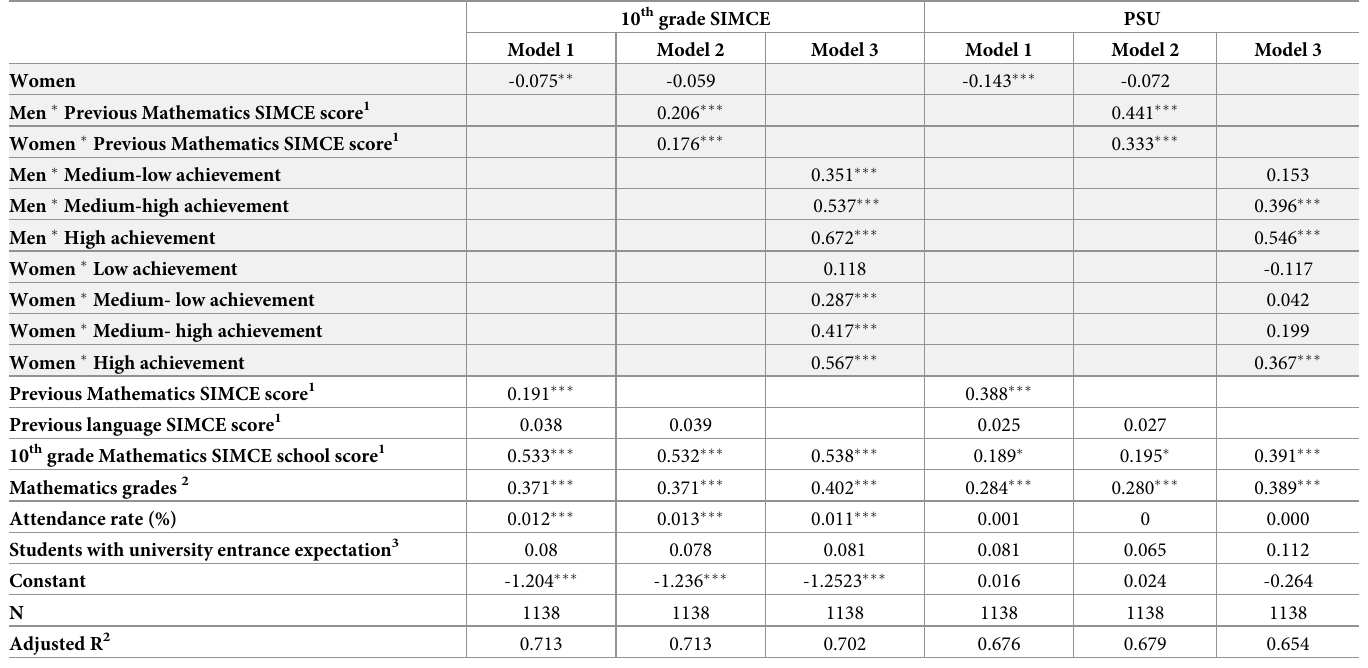
Table 4. Estimated coefficient. Models to predict Mathematics performance in competitive (PSU) and noncompetitive (10 th grade SIMCE)